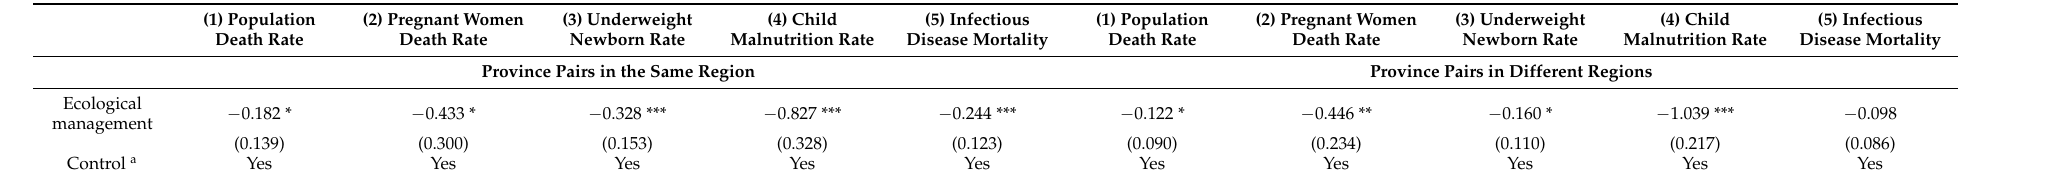
Table 5. Heterogenous regions: province pair in identical region vs. different regions (Baseline model).